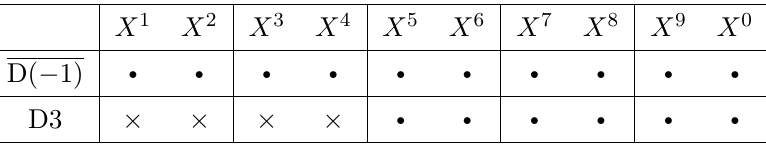
Table 1 . N = 4 SYM